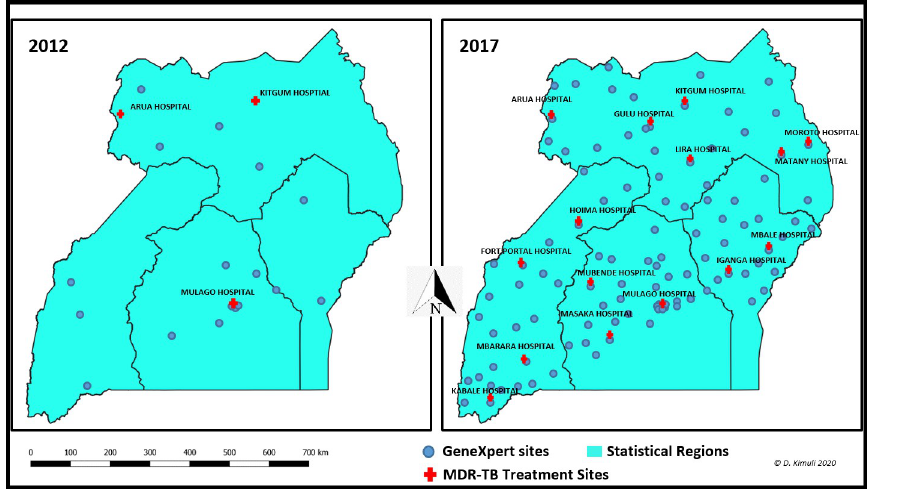
Fig 2. GeneXpert machines and DR-TB treatment sites in 2012 and